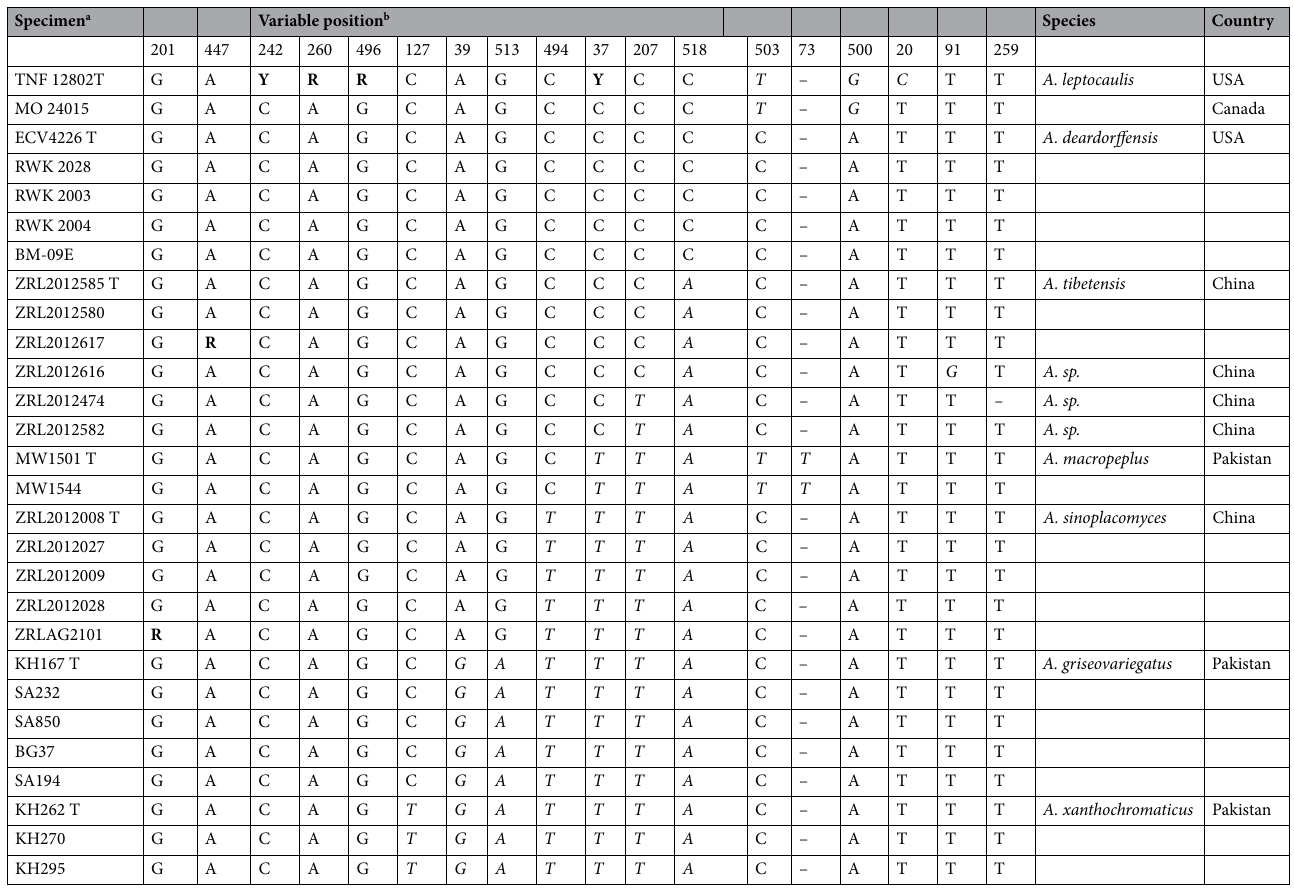
Table 2. Comparison of 15 ITS sequences of three new species ( A. macropeplus , A. griseovariegatus and A. xanthochromaticus ) with 13 sequences of closely related taxa. Nucleotides differing from the most consensual sequence ( A. deardorffensis ) are highlighted in italics. Heteromorphisms reflecting intraspecific polymorphisms are highlighted in bold. Specimens and variable positions are arranged in order to facilitate comparison between species. a Genbank accession numbers of 19 specimens used in the phylogenetic analysis are given in the ITS tree of Fig. 1 and in Table 1. Those of the nine remaining samples are given in Material and Methods. b Variable characters are numbered according to their positions in an alignment including the 28 ITS sequences used in the